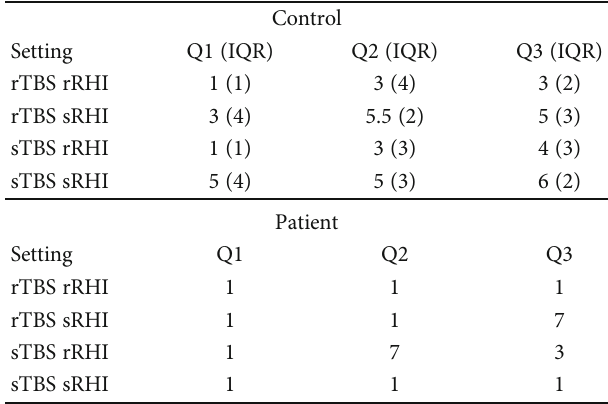
Figure 5: Comparison of the proprioceptive drift of the patient and the healthy control group in centimeters. The whiskers extend to the minimal and maximal data points. rRHI: real rubber hand illusion; sRHI: sham rubber hand illusion; rTBS: real theta burst stimulation; sTBS: sham theta burst stimulation. Table 3: Questions 1-3 in median score points and interquartile range (IQR) in the control group and the